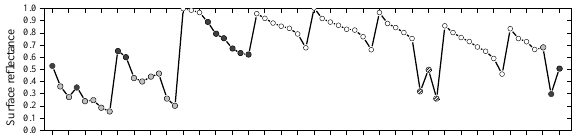
Figure 1. Temporal characteristics of snow and clouds on multi- temporal GOCI data during eight days periods (white circle: clear, grey circle: clouds, stripe: shadow)